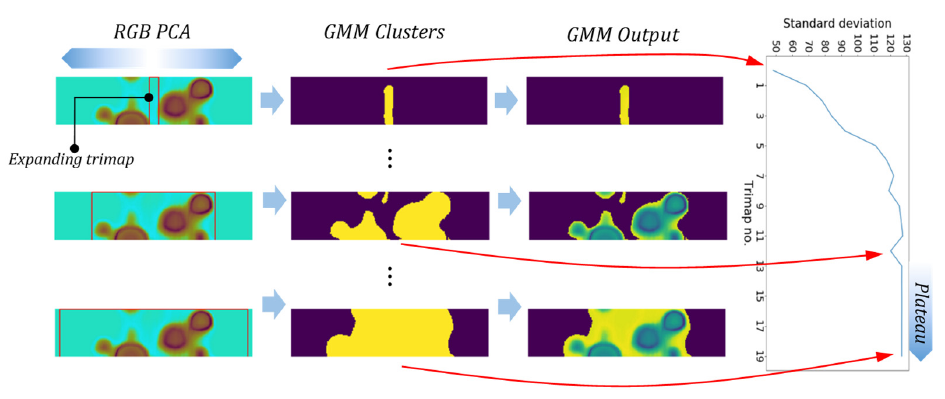
Figure 13. Example of expanding trimap operation and the segmentation convergence criteria.